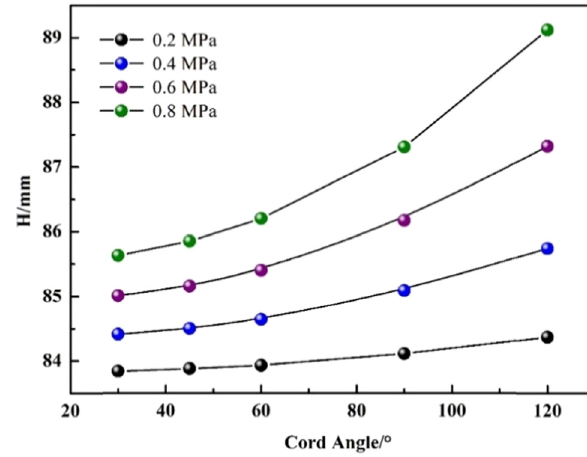
Figure 11: Bump pro fi le under di ff erent cord angles.